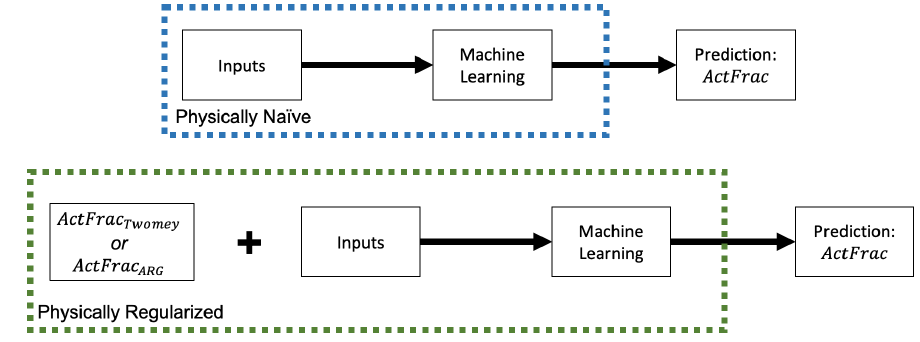
Figure 1. Schematic diagram of the emulator construction for the physically naïve and physically regularized emulators.